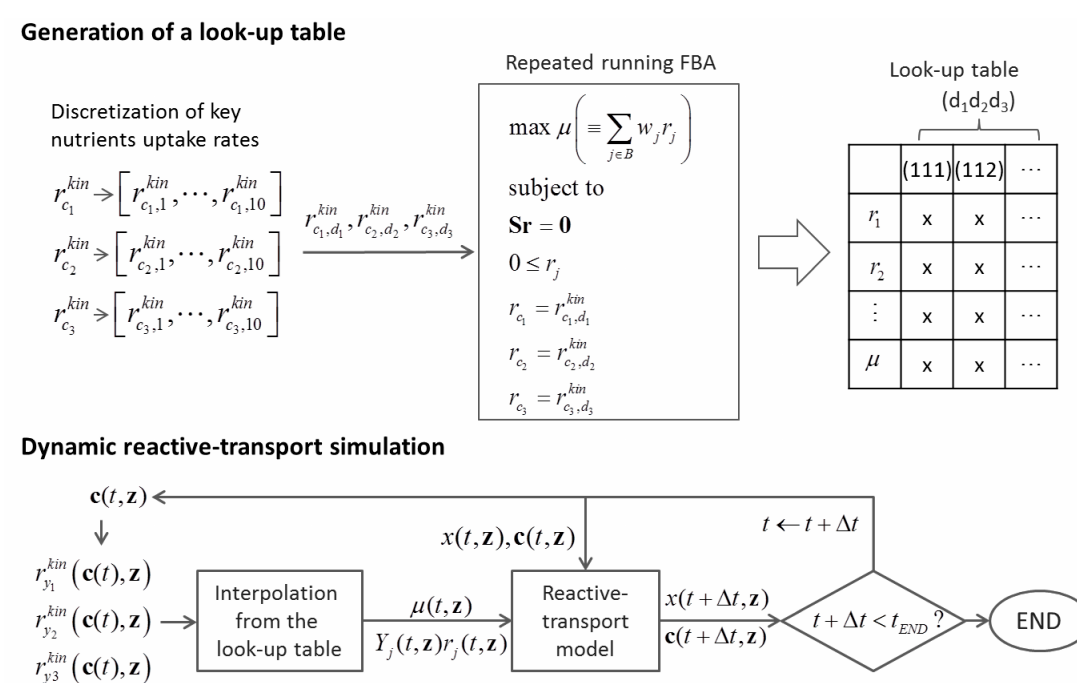
Figure 10. Indirect coupling between a reactive-transport model with FBA for the dynamic simulation of a single organism growth. One should first generate a look-up table through the repeated running of FBA with a large number of different sets of nutrient uptake rates (which is 1000 in total in this example) generated by discretizing the range of each uptake ( top ). During the dynamic simulation of the reactive-transport model, the growth rate and metabolite production rates are updated at each time/location from the look-up table ( bottom